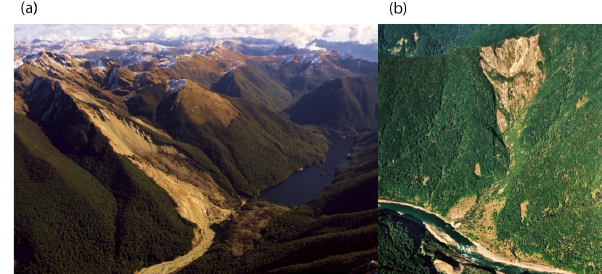
Figure 4. (a) Lake Stanley rock avalanche. The lake was dammed by the landslide, which was triggered by the 1929 earthquake. (b) 1995 photo of a rock avalanche that dammed the Buller River during the 1968 earthquake. Apart from vegetation growth, the scar has changed little in the last 40